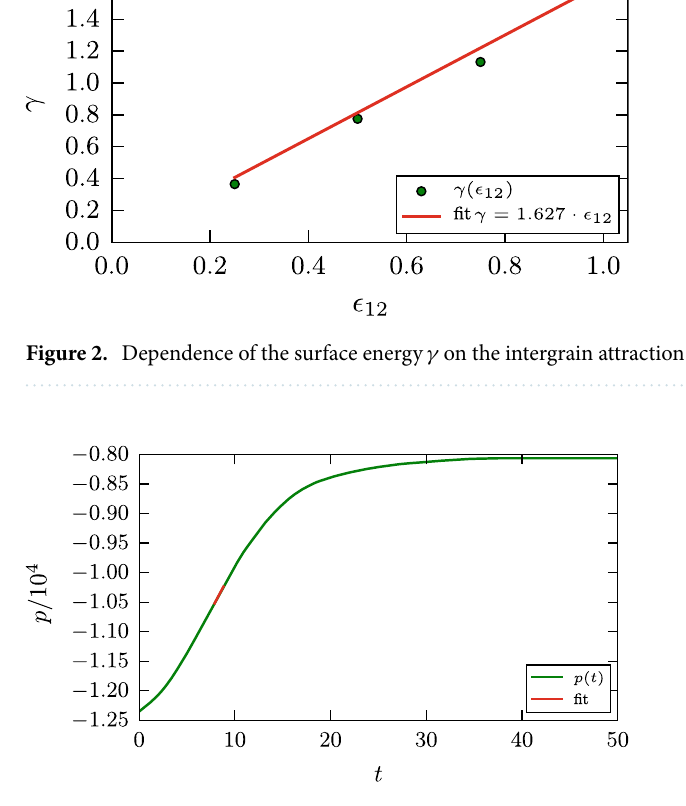
Figure 3. Temporal evolution of the relative momentum p in a separation simulation of two grains at an initial value of the relative velocity of v = 0.247 with ǫ 12 = 0.75